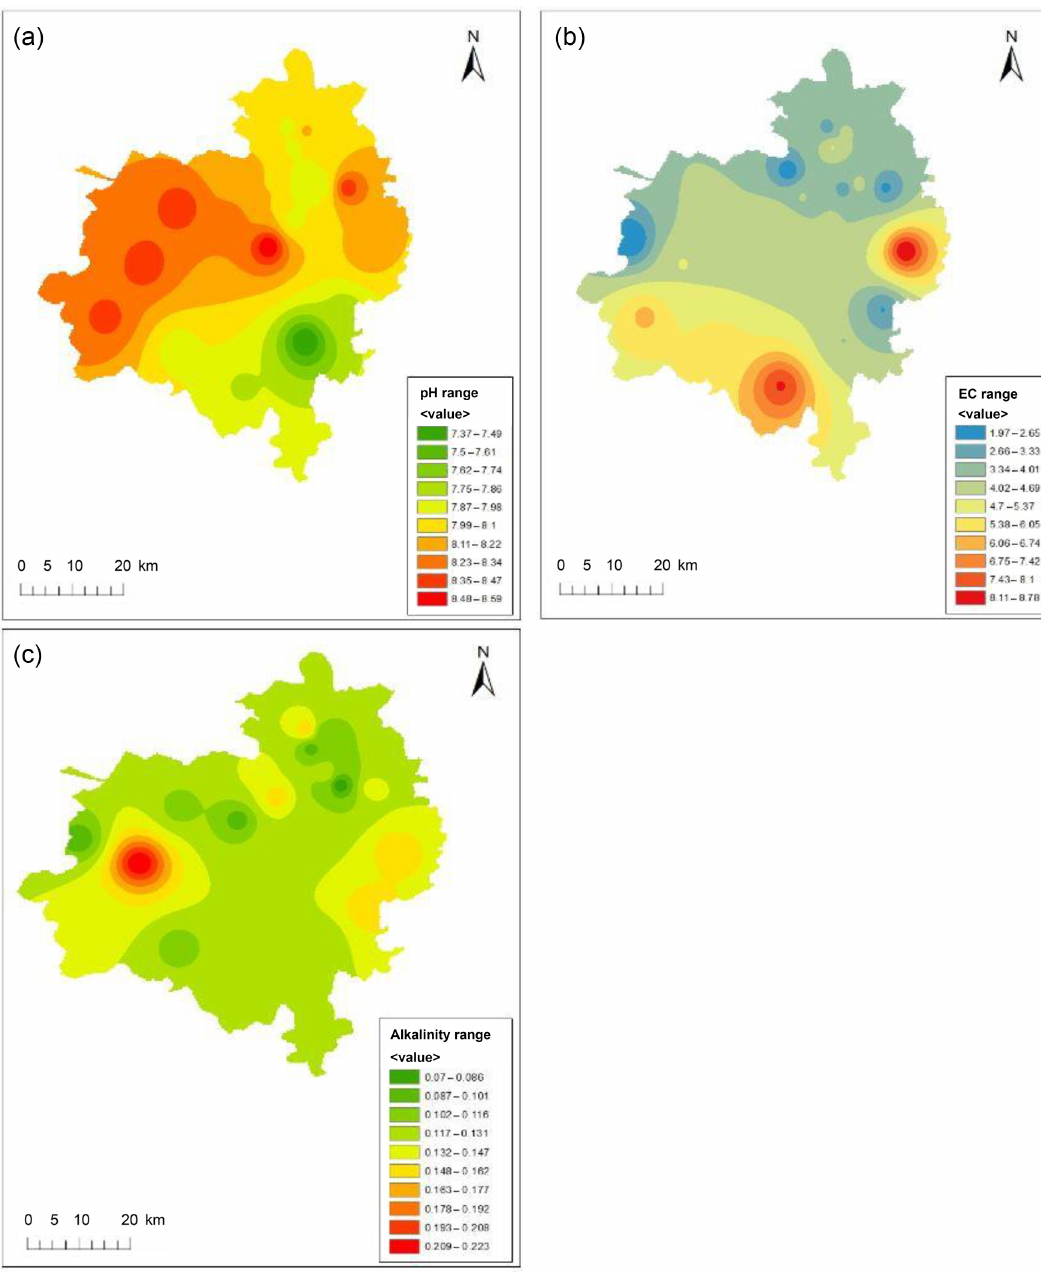
Figure 6. (a) Soil map of the Bathinda district on the basis of pH values. (b) Soil map of the Bathinda district on the basis of EC values. (c) Soil map of the Bathinda district on the basis of alkalinity